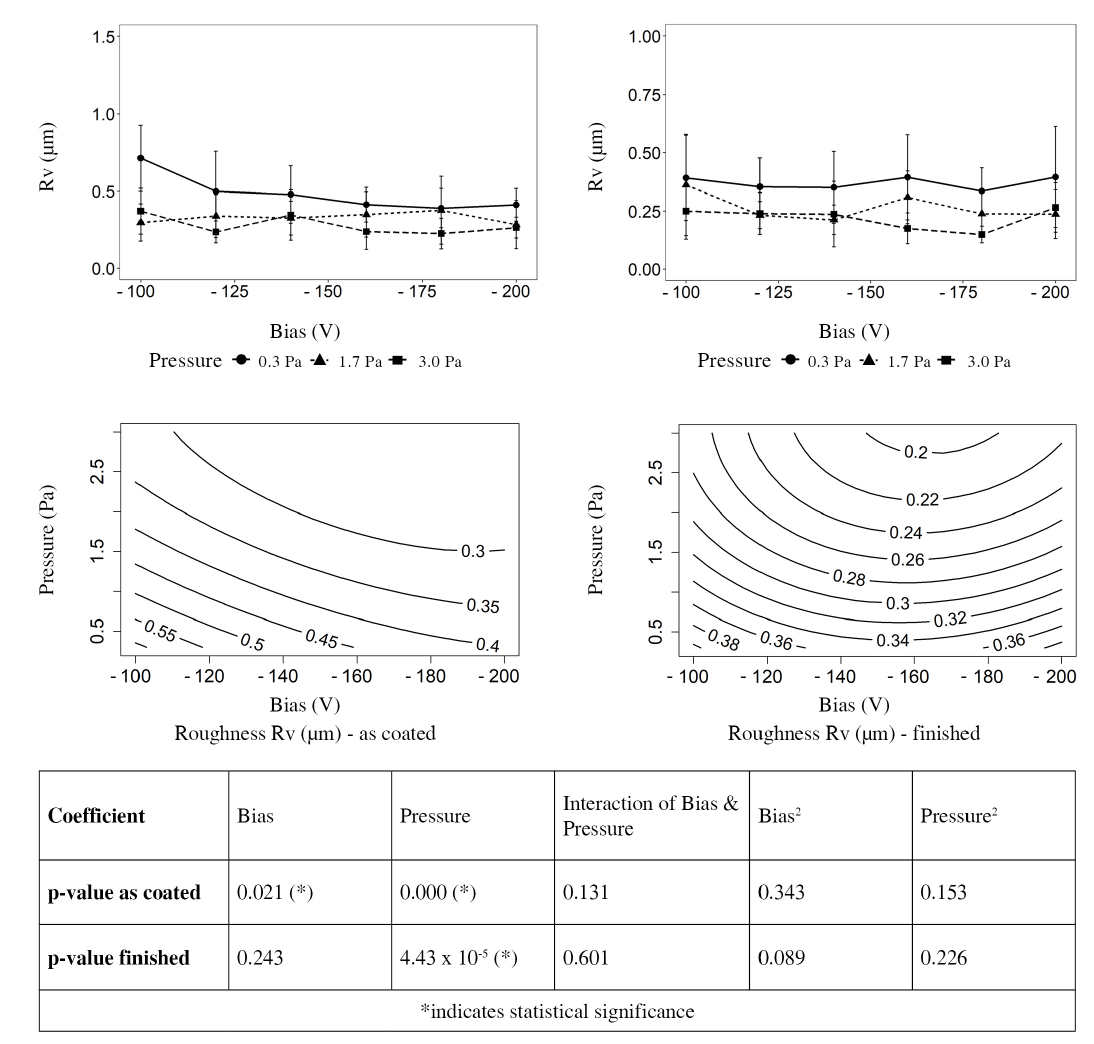
Figure 5. Scatter plots and response surface of the line roughness Rv as coated and finished.